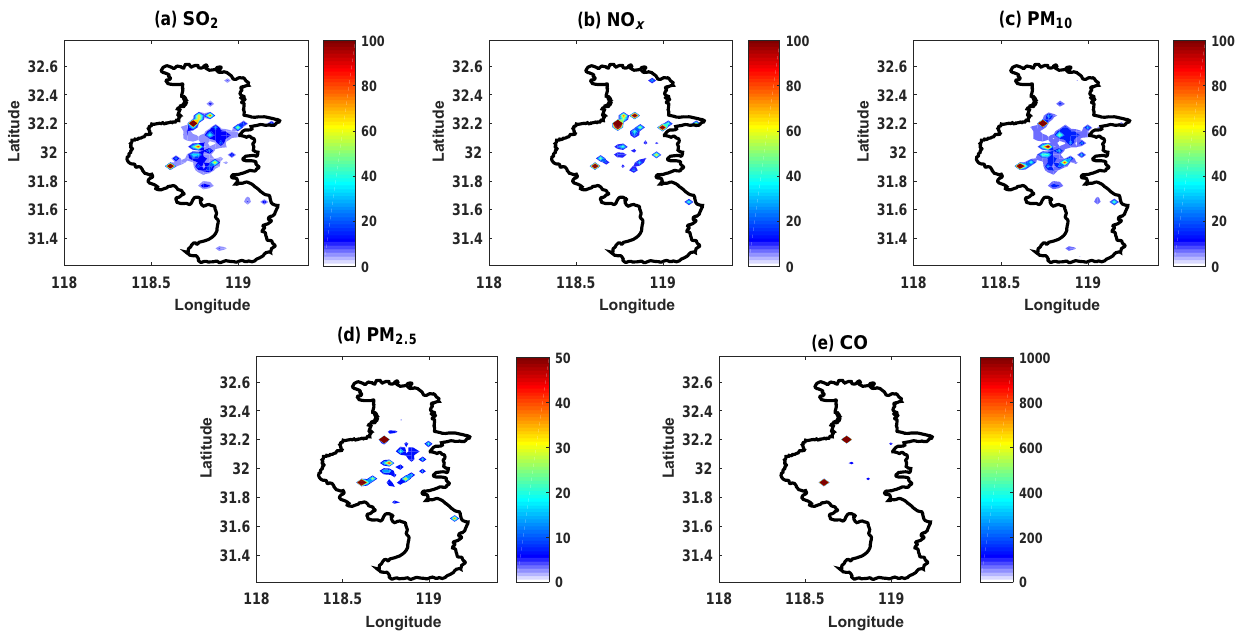
Figure 2. Emission reduction in domain 4. (a) SO 2 , (b) NO X , (c) PM 10 , (d) PM 2 . 5 , (e) CO (tmonth − 1 ).